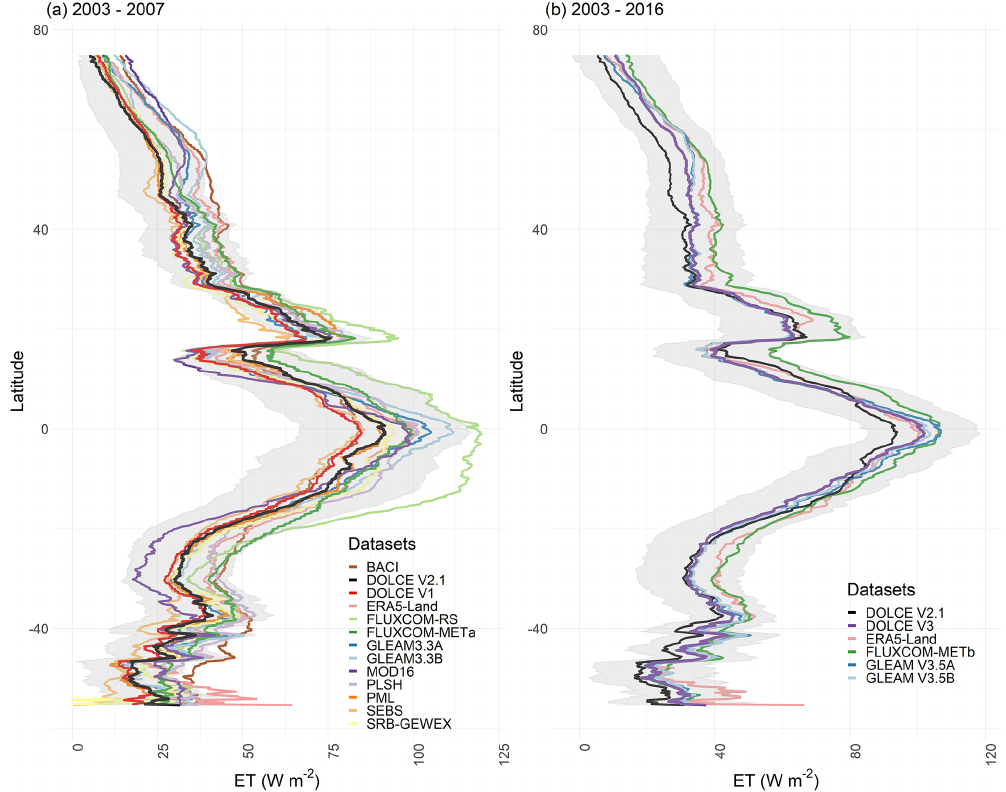
Figure 1. (a) Latitudinal means of DOLCE V2 and its parent datasets computed over a common period 2003–2007 and a common spatial mask. (b) Latitudinal means of DOLCE V3 and its parent datasets computed over a common period 2003–2016 and common spatial mask. The grey ribbon represents the values of DOLCE ± uncertainty. DOLCE V1 and DOLCE V2 are included in (a) and (b) respectively for comparison. FLUXCOM-METa and FLUXCOM-METb are two different datasets from the FLUXCOM-MET